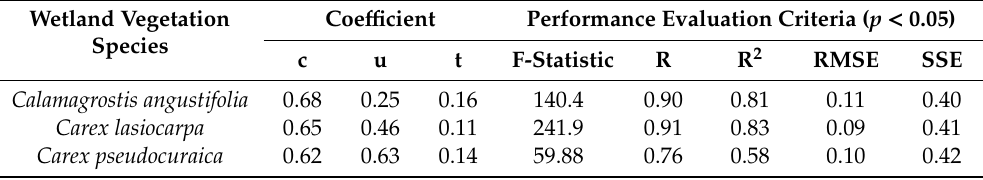
Table 1. The coe ffi cient obtained from the Gaussian regression model for each species, together with the error indices.